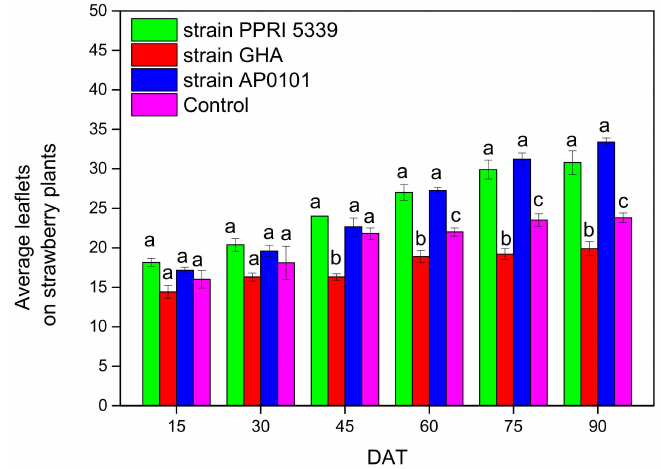
Figure 12. Average number of leaflets of Fragaria sp. plants inoculated with B. bassiana. Each treated plant was watered with 10 mL of 10 8 conidia/mL suspension at the stage of four leaves (November 2021), and after 4 months (March 2022), means of the same DAT marked with the same letter did not differ significantly (Tukey-Kramer test, p < 0.05); DAT: days after treatment.